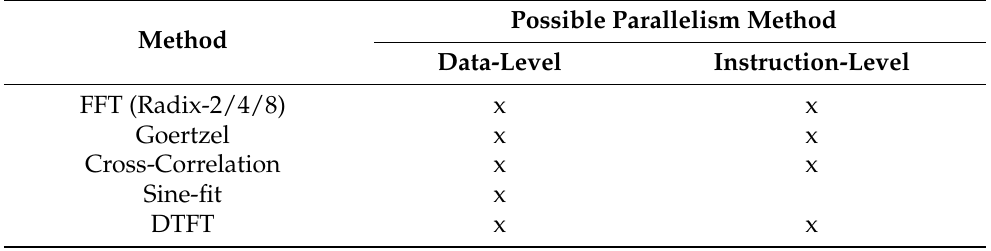
Table 2. Efficient Hardware Acceleration Methods for AC signal analysis Methods Treated in this